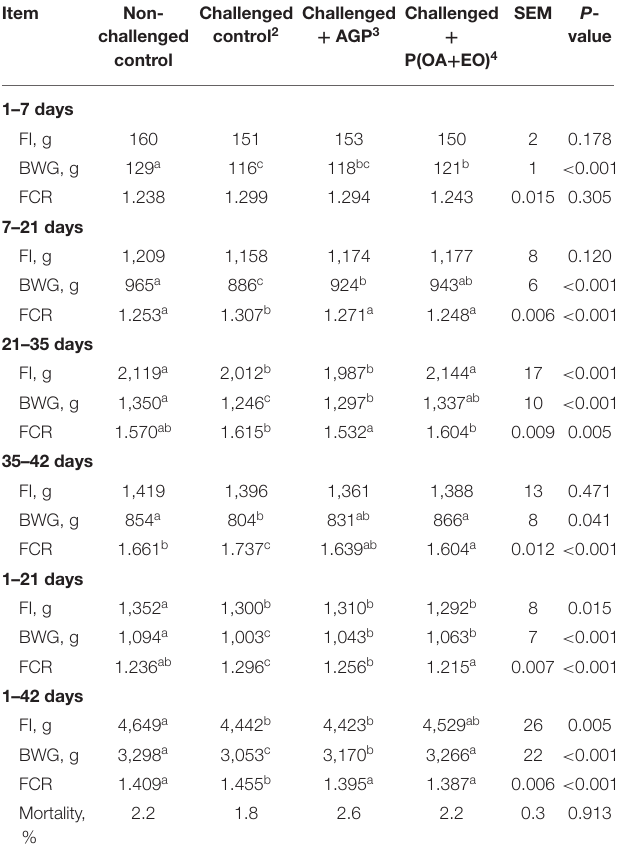
TABLE 3 | Growth performance of broiler chickens undergoing an intestinal challenge and fed diets supplemented or not with an antibiotic growth promoter (AGP) or a protected blend of organic acids and essential oils [P(OA + EO)] 1